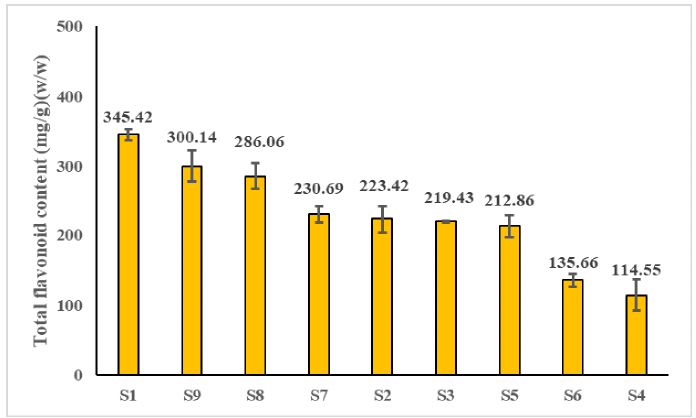
Figure 1. TFCs of Woodwardia japonica from different districts (mg/g) ( w / w ). Antioxidant activities of W. japonica from different districts were obviously different. IC50 (including scavenging activities of DPPH·, ABTS·, O 2 − ·) and reducing force on Fe 3+ of W. japonica from different districts were showed in Figure 2. W. japonica from Wuyi Mountain (Jiangxi Province) showed the strongest scavenging to DPPH radicals and reducing force on Fe 3+ , but weaker on eliminating ABTS radicals and superoxide anion radicals. However, W. japonica from Fengyang Mountain showed the strongest radical scavenging activity to ABTS radicals and superoxide anion